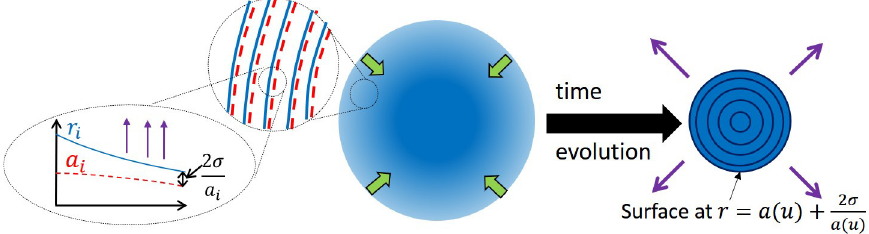
Figure 5. Left: The collapsing matter can be considered as consisting of many shells. Right: It evolves to a dense object with a surface at r = a ( u ) + 2 σ a ( u )